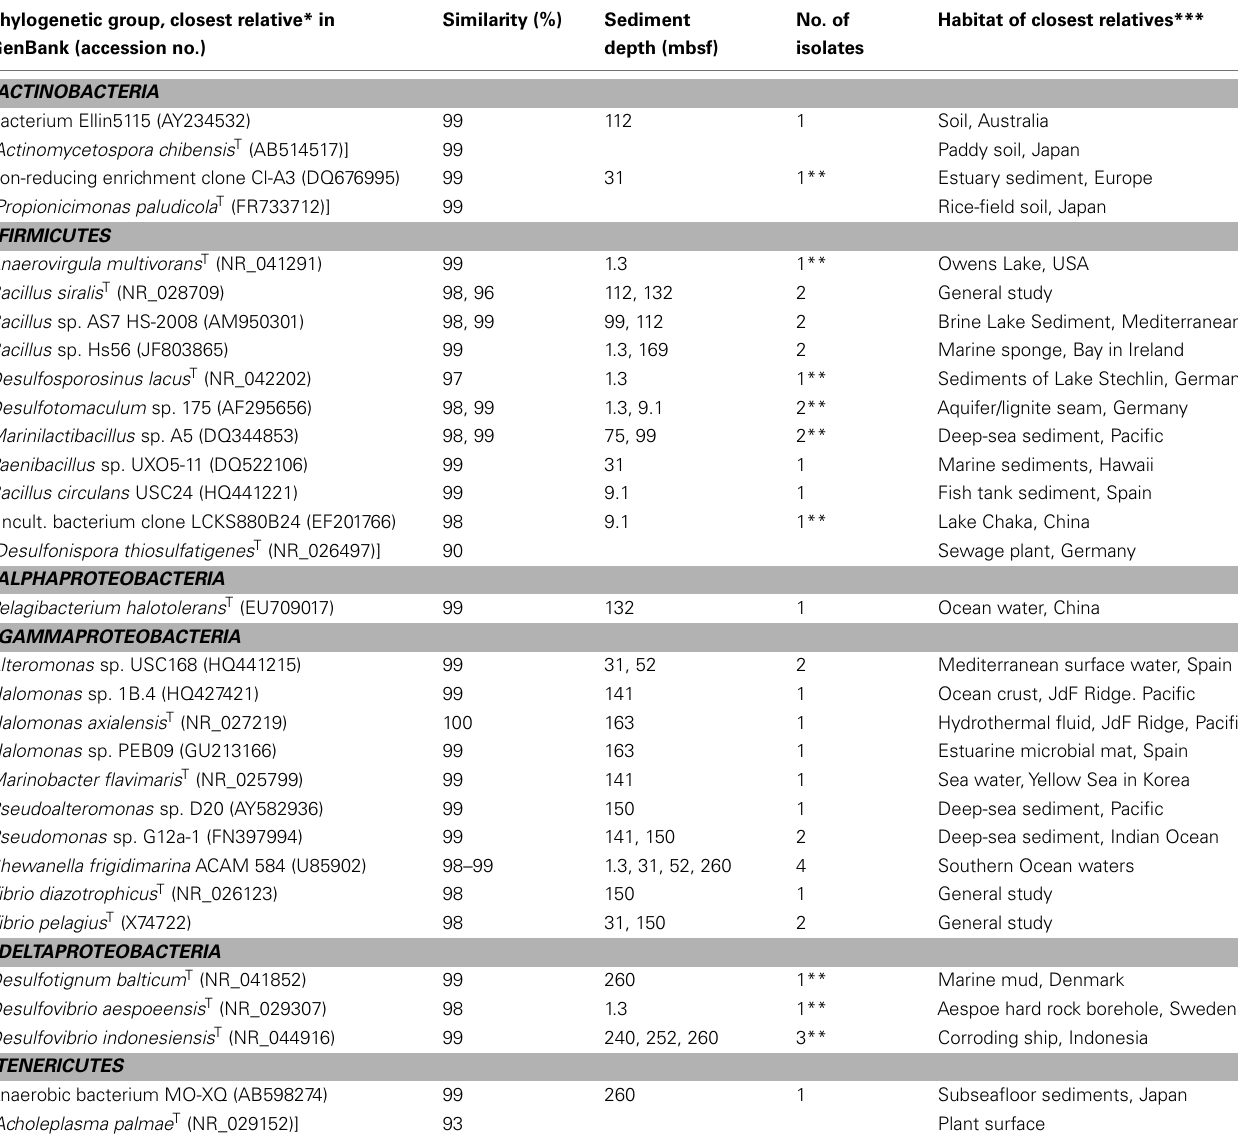
Table 1 | Origin and phylogenetic affiliation of isolated strains from IODP Site U1301, a 265-m-long sediment column of the eastern flank of the Juan de Fuca Ridge, Northeast